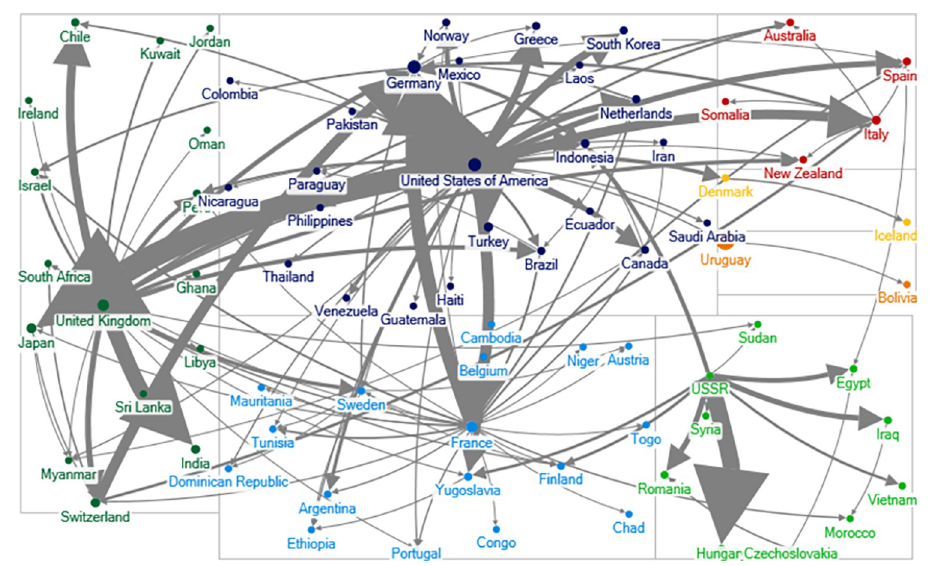
Fig 5. Arms export network in 1960. The lines are directed arrows and run from suppliers to recipients. The width of the line is related to the export volume.